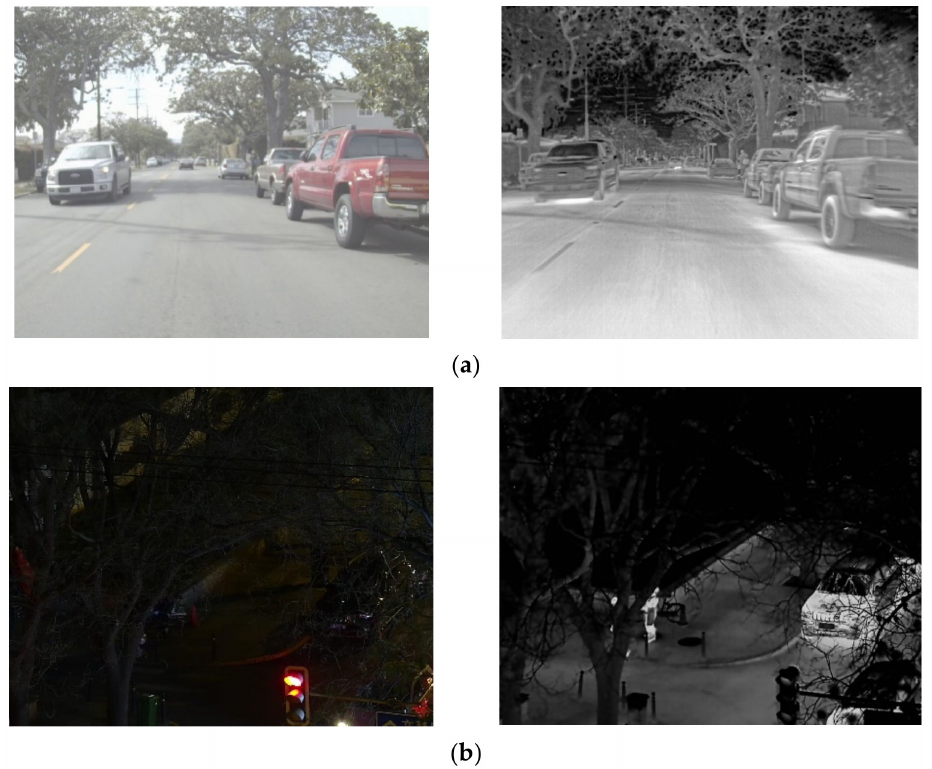
Figure 3. RGB-IR image pair on ( a ) a bright day and ( b ) at